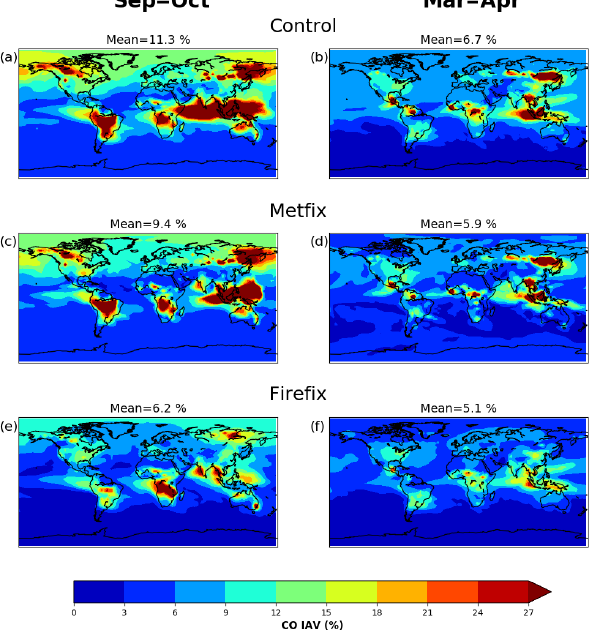
Figure 5. The calculated interannual variability (coefficient of variation) of CO over the period 1997–2014 for September– October (a, c, e) and March–April (b, d, f) from (a, b) the con- trol simulation (CTRL), (c, d) fixed meteorology (METFIX) and (e, f) fixed fire emissions (FIREFIX).